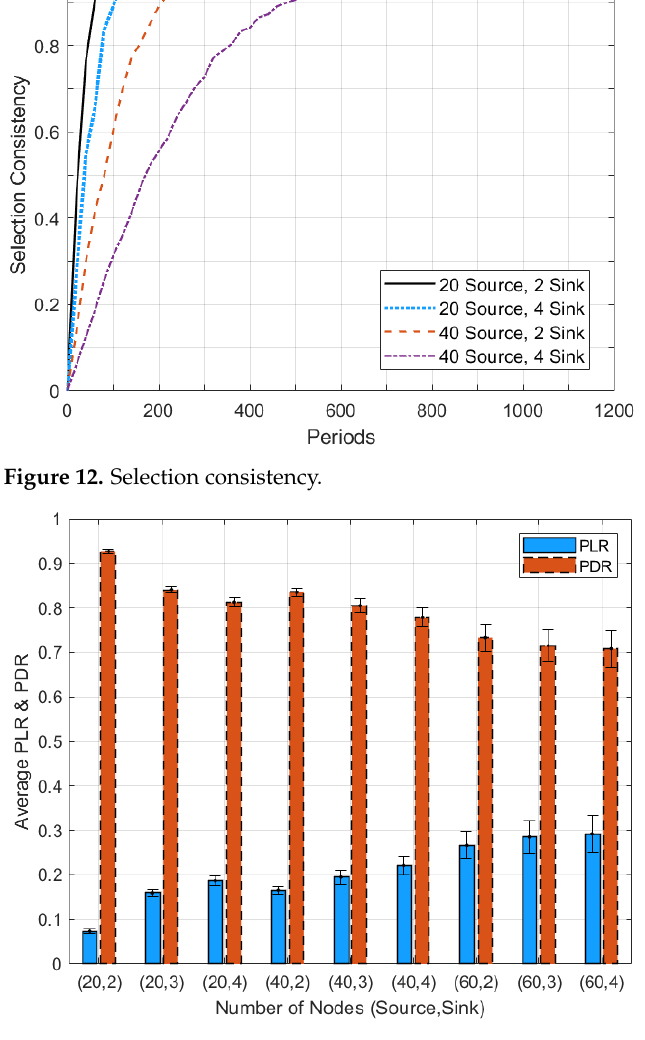
Figure 13. Average PLR and PDR with different